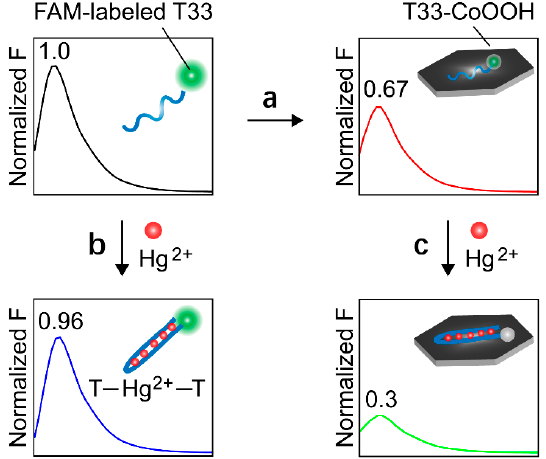
Figure 1. Schematic illustration and fluorescence emission spectra change of an artificial molecular system based on molecular interactions among polythymine oligonucleotide T33, metal ions (Hg 2+ ), CoOOH nanosheets. ( a – c ) the formation of T33–CoOOH ( a ); T–Hg 2+ –T pairs ( b ); T33–CoOOH–Hg 2+ ( c ). T33: 100 nM, CoOOH nanosheets: 4.69 µ g/mL, Hg 2+ : 10 µ M. The excitation and emission wavelength are 485 and 520 nm. The fluorescence intensity is normalized. Buffer: 5 mM Tris-HCl buffer solution (pH 7.4); FAM: carboxyfluorescein; CoOOH: cobalt oxyhydroxide.